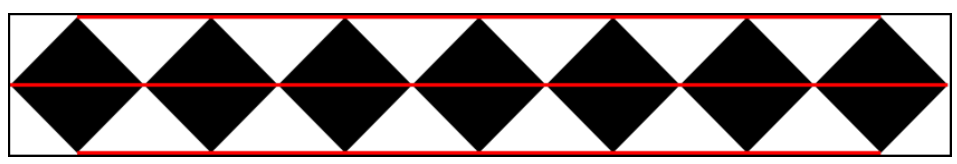
Figure 9. A segment using a vertex of diamonds.